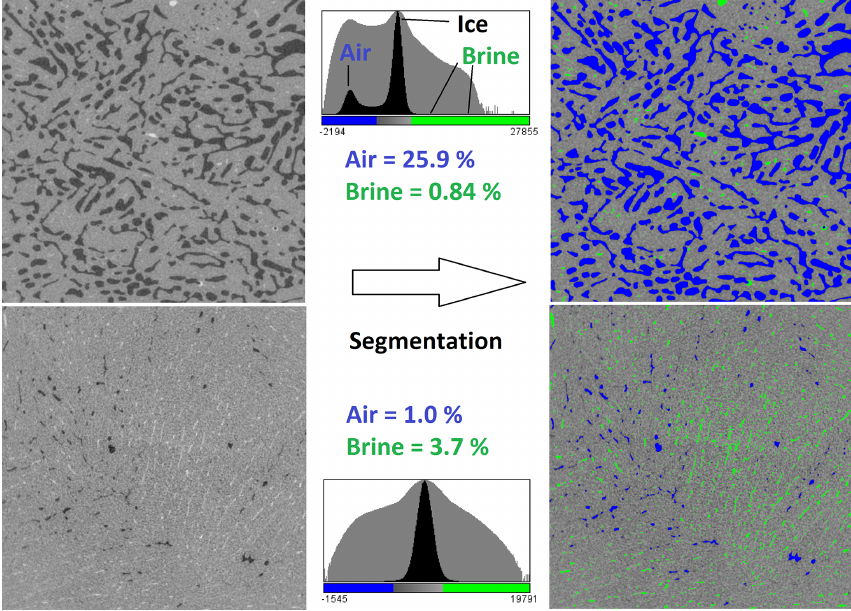
Figure 2. Segmentation of pre-filtered greyscale absorption images (left) into the classes of air (blue), brine (green) and ice (grey) for a high-porosity (upper) and low-porosity (lower) image. The images in the middle give the histograms of grey values with a linear (black) and a log (grey) scale. Upper example: a high-porosity image with a well-defined air peak, yet little entrapped brine. Lower example: a sample with more entrapped brine than air or centrifuged